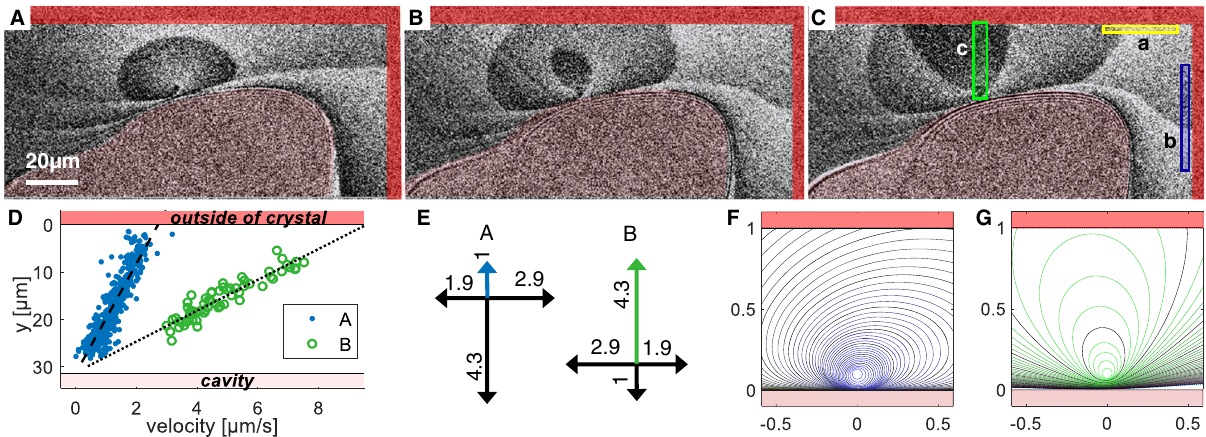
Fig. 3 | Spiral growth in nanocon fi nement. A – C Average subtracted RICM image series at a bulk supersaturation σ =0.002 with 3-s intervals. The areas outside the crystalandinsidethecavityaremarkedinrespectivelyredandlightredcolors.The oval regions of different intensities (gray levels) are molecular layers 0.33nm in heighteach.Theregionsaand bin( C )havebeenselected forthedeterminationof the step fl ow velocities along the outer rim boundaries. The green region c in ( C ) was selected to determine position (concentration) dependencies of step fronts